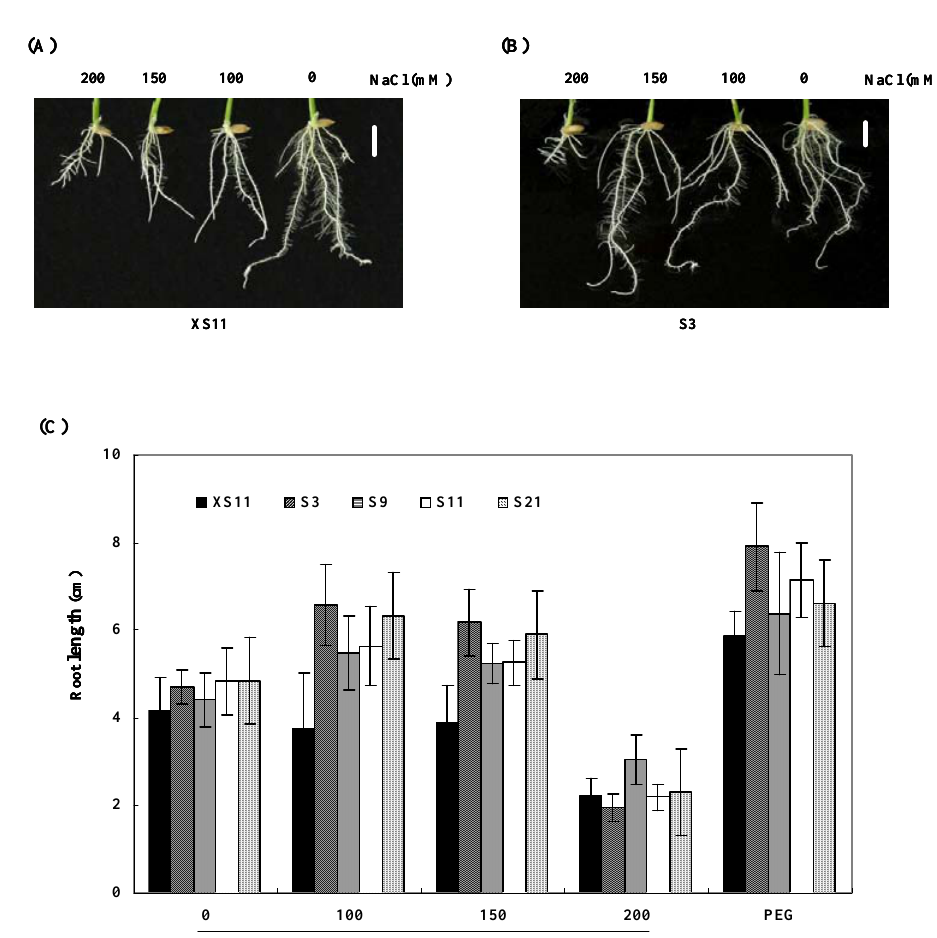
Figure 2. Effect of salt stress on rice seedlings of control and transgenic